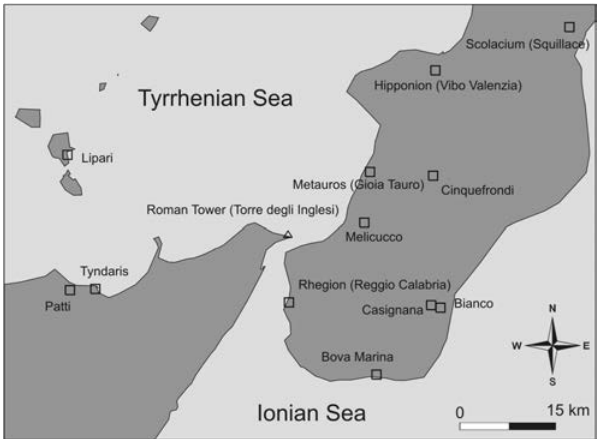
Figure 11. a) Maximum intensity data point distribution (I=7-9 MCS) for the 6 February, 1783 earthquake [data from Boschi et al. 2000]. Lo- cations affected by tsunami are also shown [data from Gerardi et al.